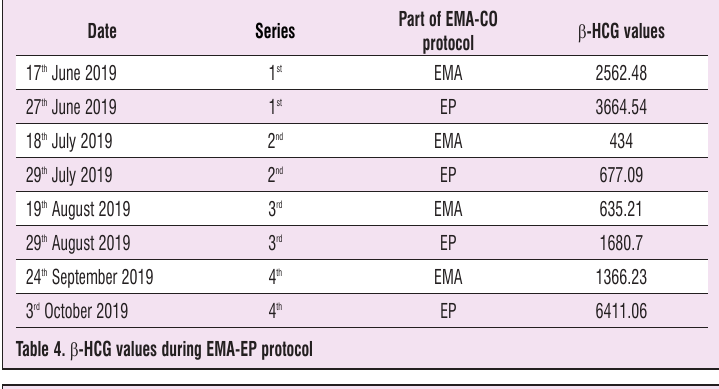
Table 3. β -HCG values during EMA-CO protocol